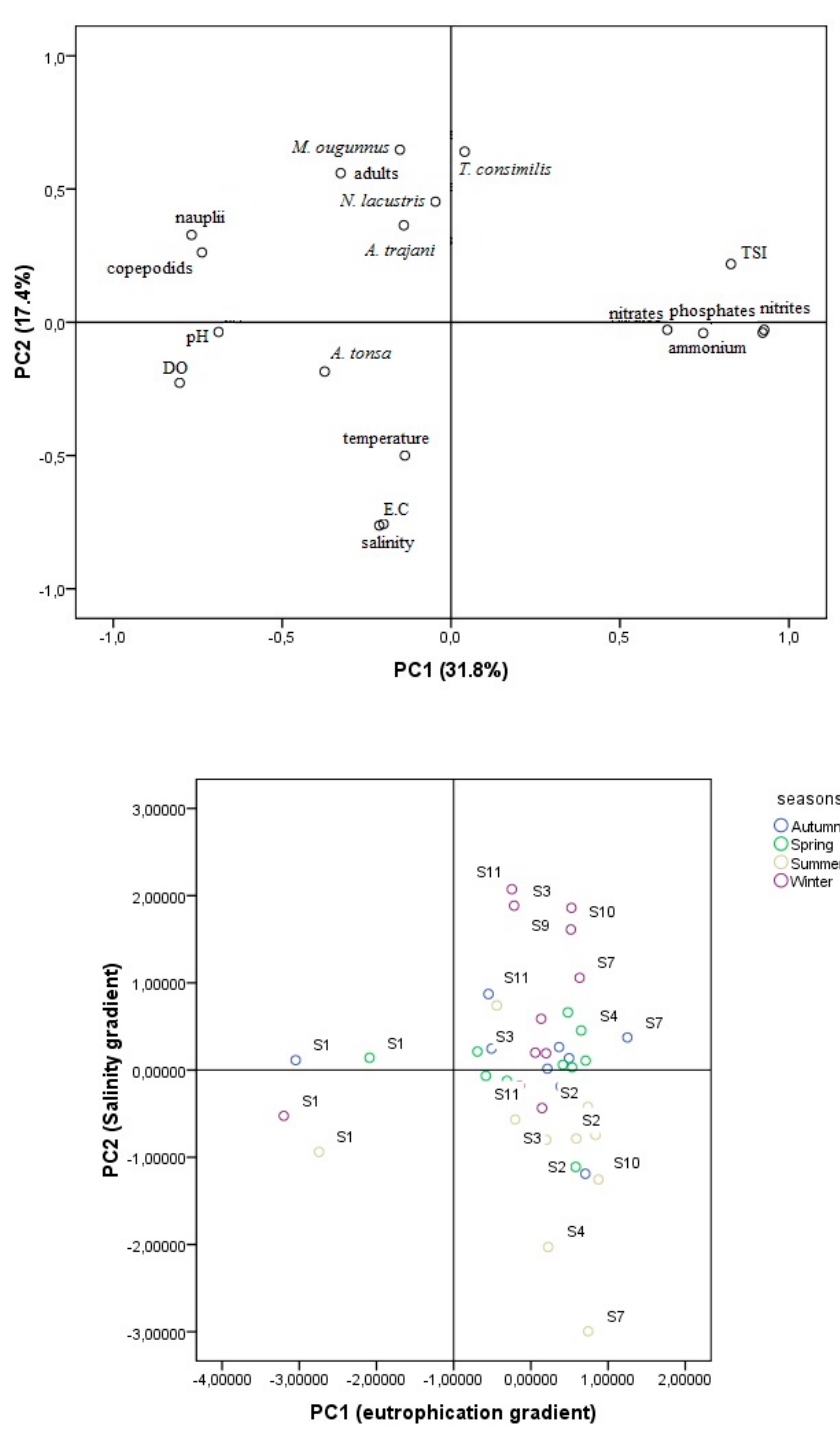
Figure 8. Principal components analysis (PCA): ordination model, with rotation of varimax axes, of variables (above) and stations and seasons (below), in plane of first two principal components.